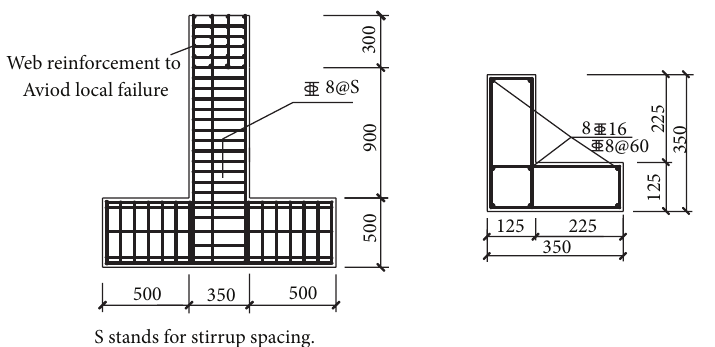
Figure 1: Section dimension and reinforcement details of L-shaped